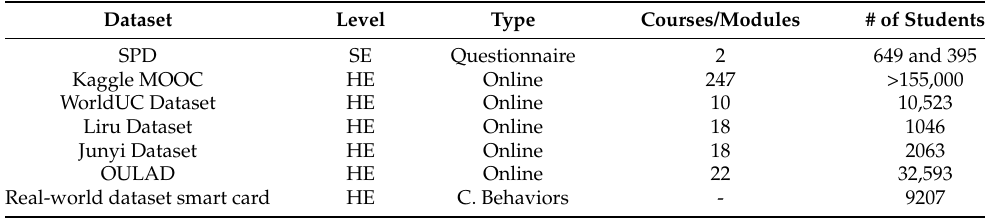
Table 3. Common datasets and